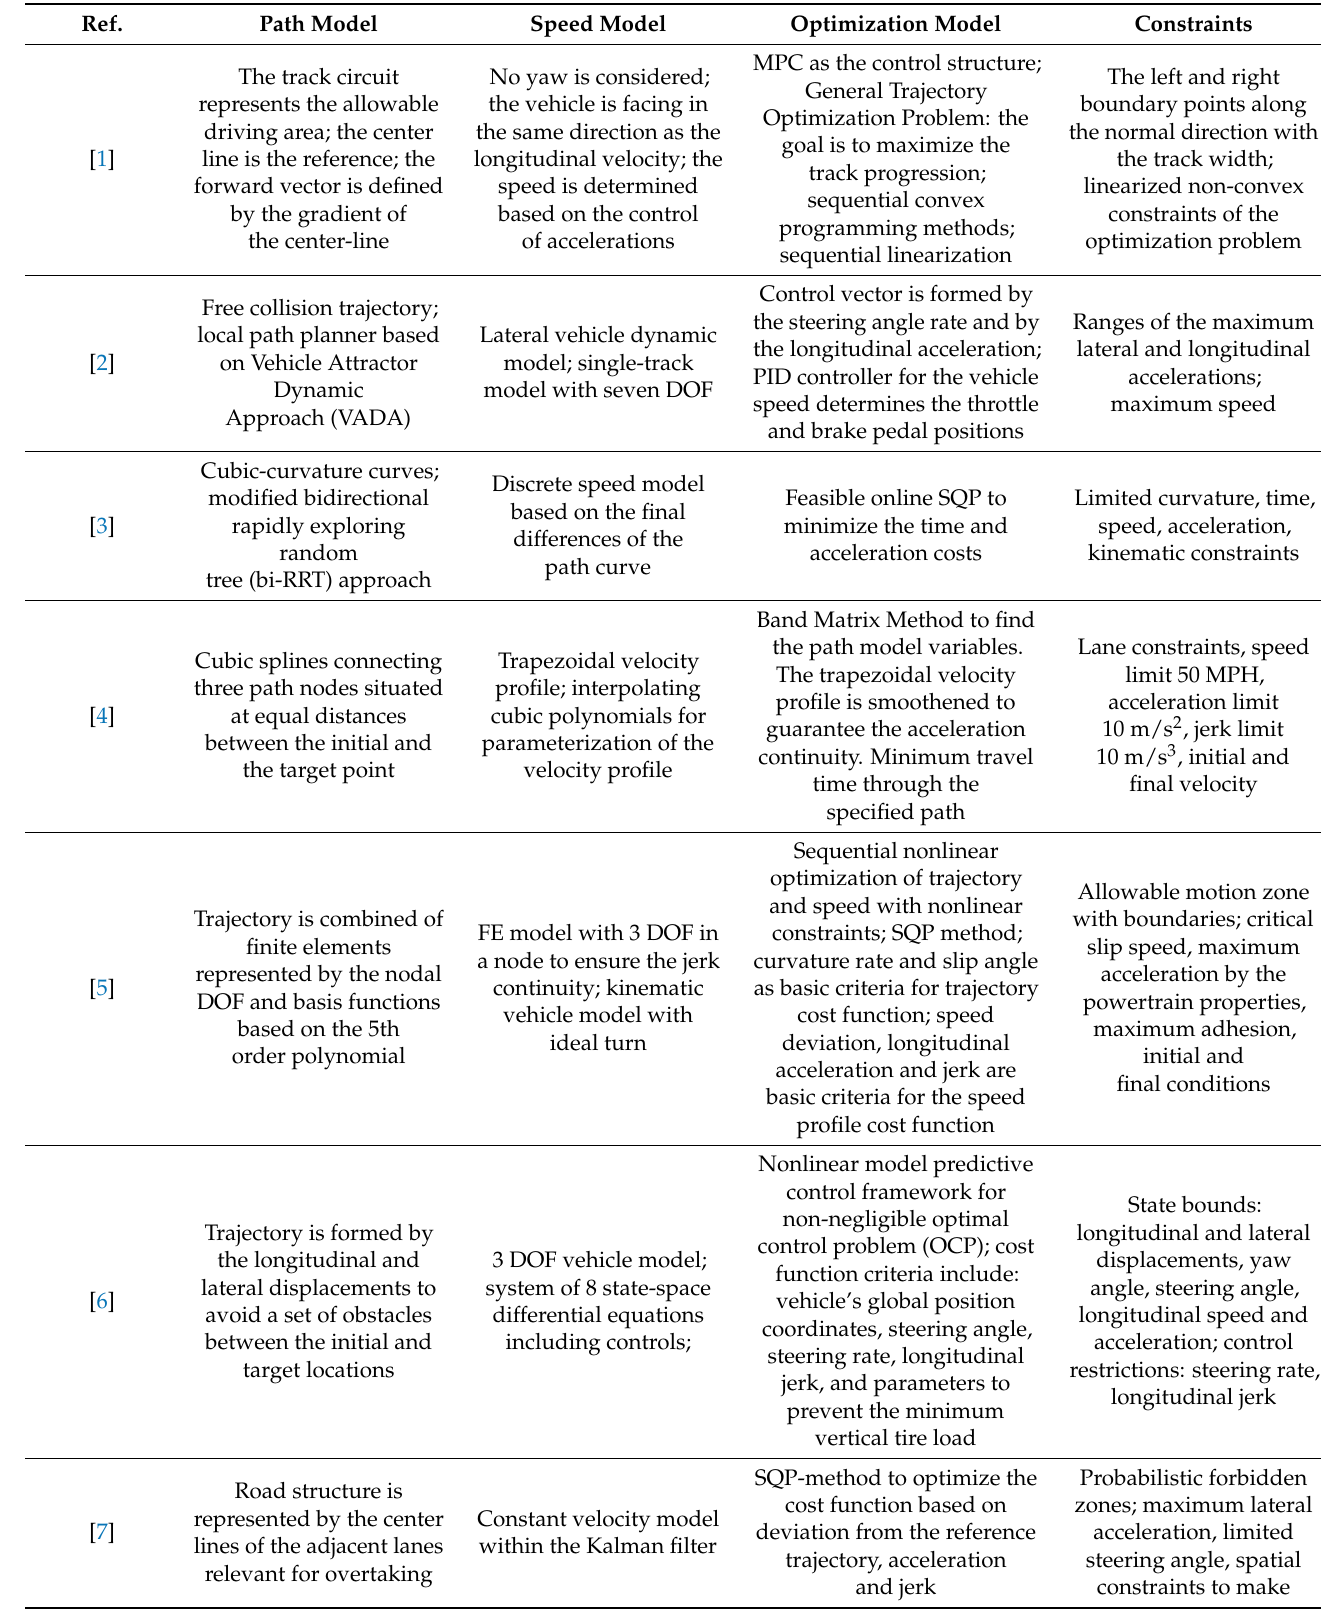
Table 1. Characteristics of selected studies on planning AV motion.